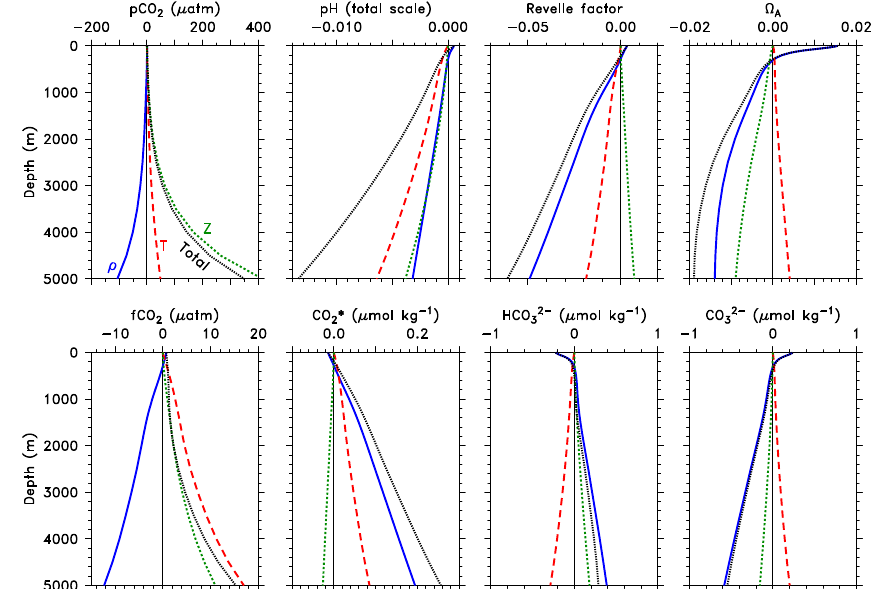
Figure 7. Absolute changes in global-mean profiles of computed variables when each of the three ocean-model approximations is avoided, with line colors and patterns as in Fig.